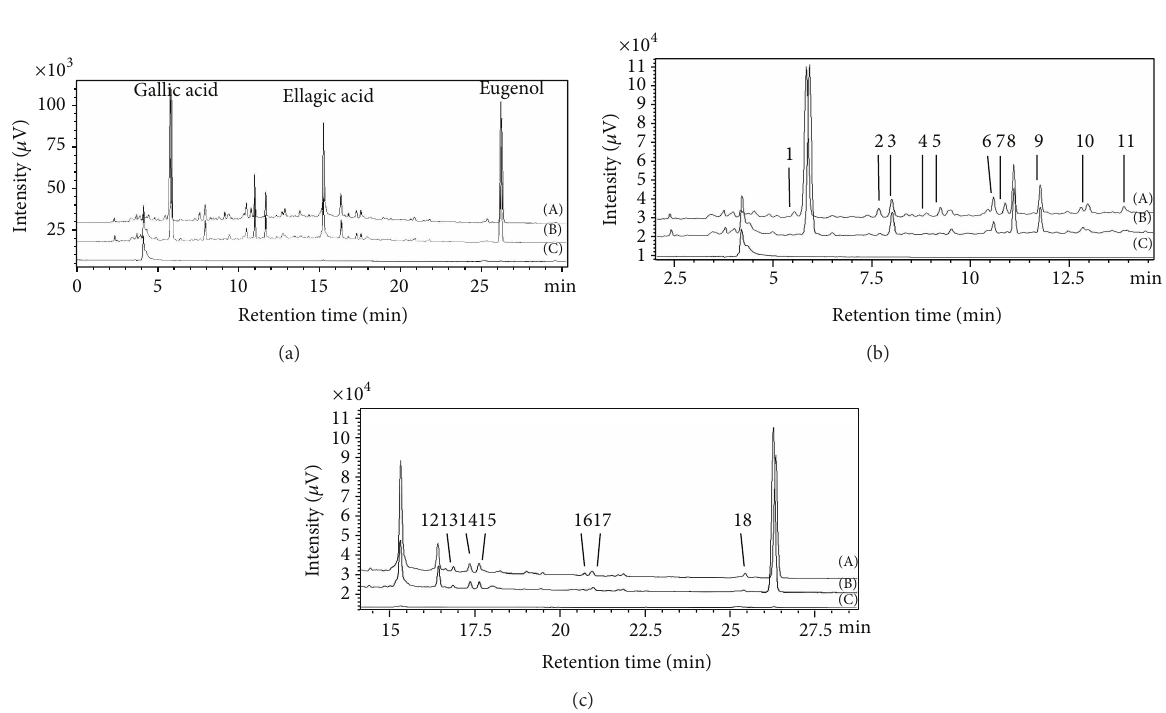
Figure 2: HPLC chromatograms of water extracts of Syzygium aromaticum (SA, A), Syzygium aromaticum combined with Curcuma aromatica (SAC, B), and Curcuma aromatica (CA, C) at the detection wavelength of 280 nm. Peaks 1–18: unidentified compounds: (a) Overall chromatogramwithin30